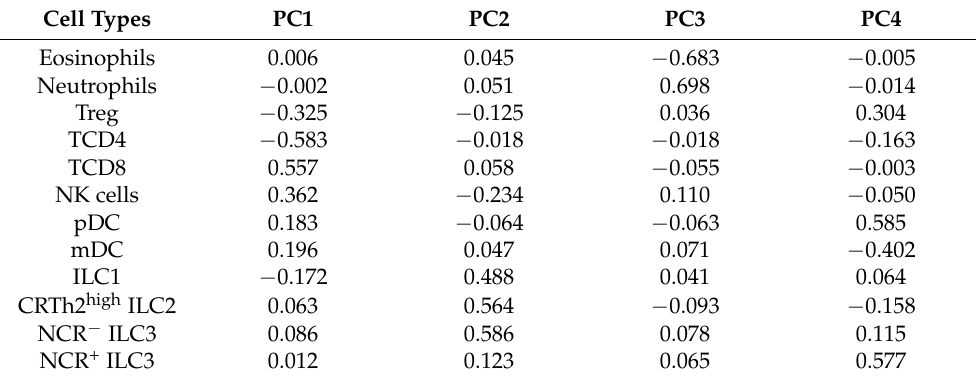
Table 3. Component loadings for cell types PC1, PC2, PC3, and PC4 after varimax rotation.